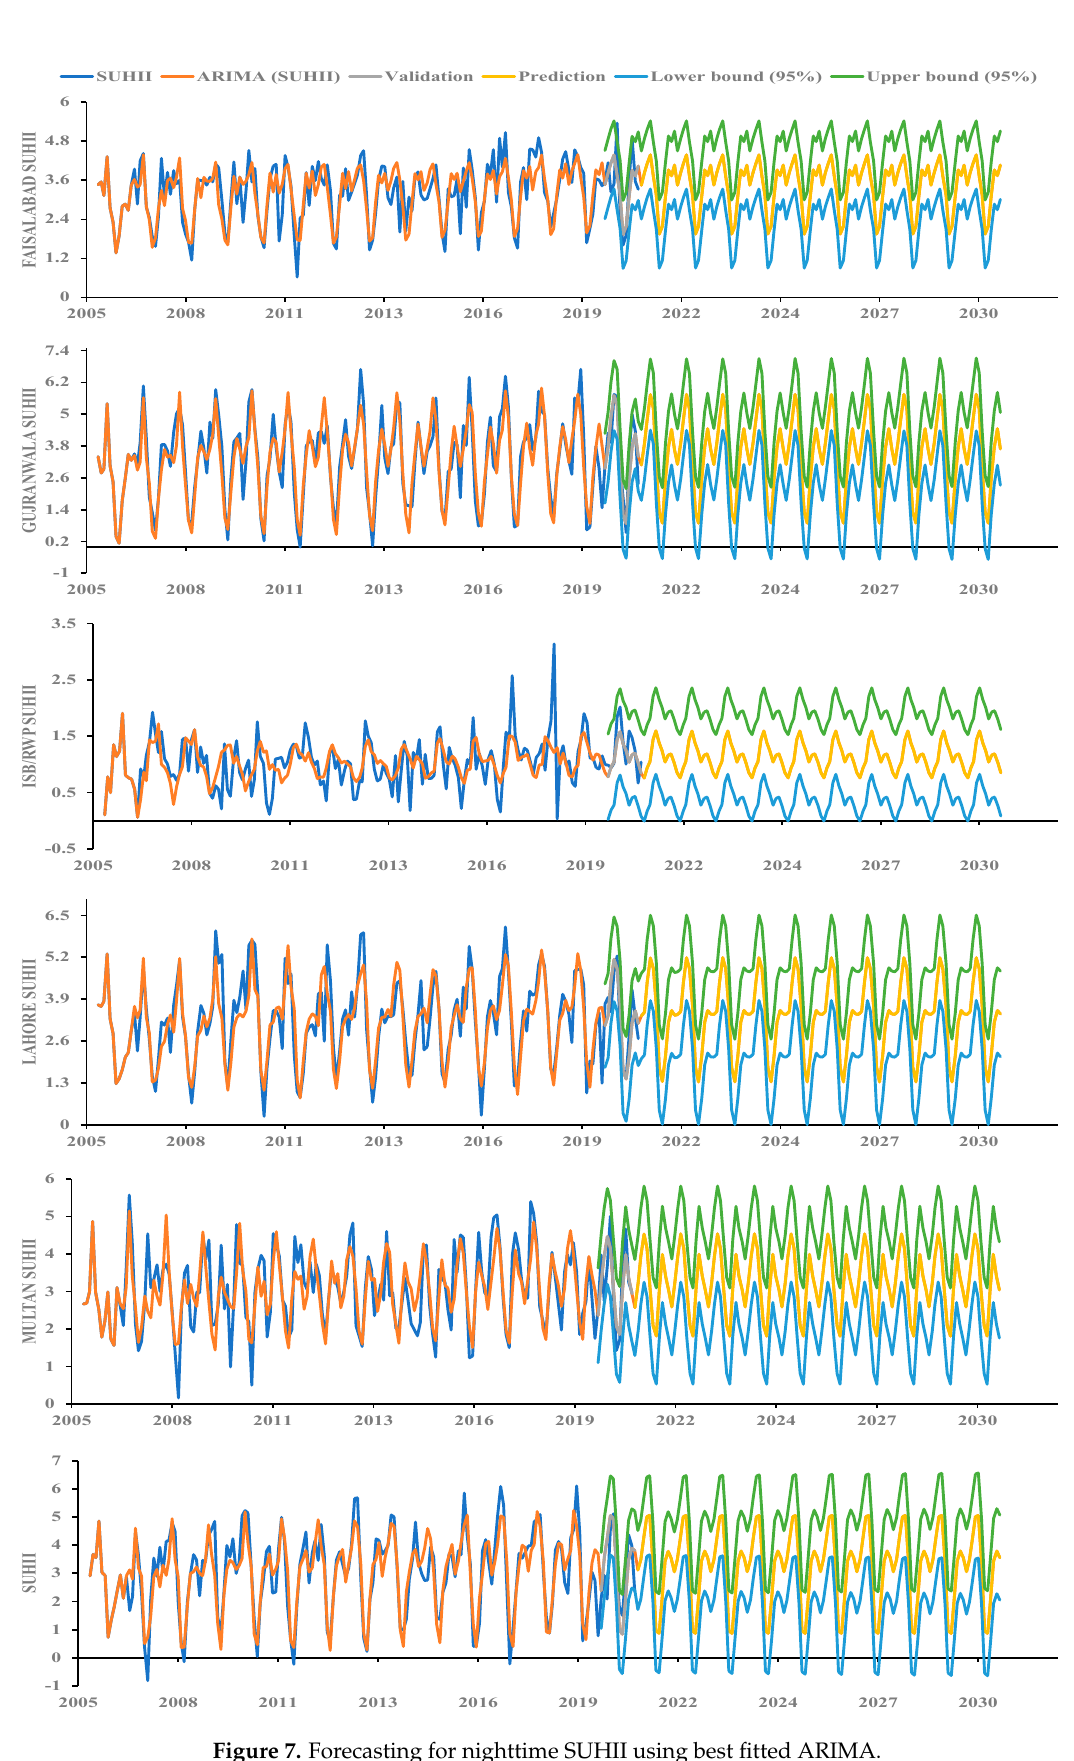
Figure 7. Forecasting for nighttime SUHII using best fitted